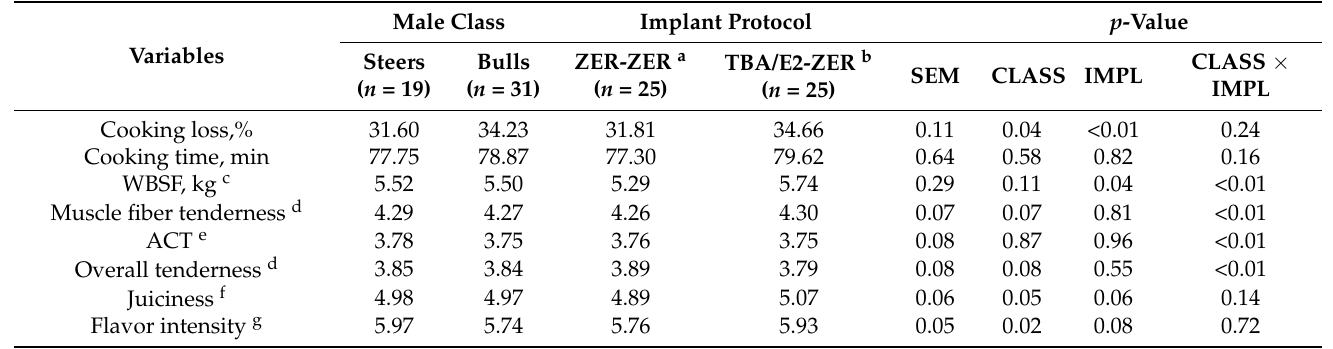
Table 10. Meat quality and cookery traits according to male class and implant protocol (Experi- ment